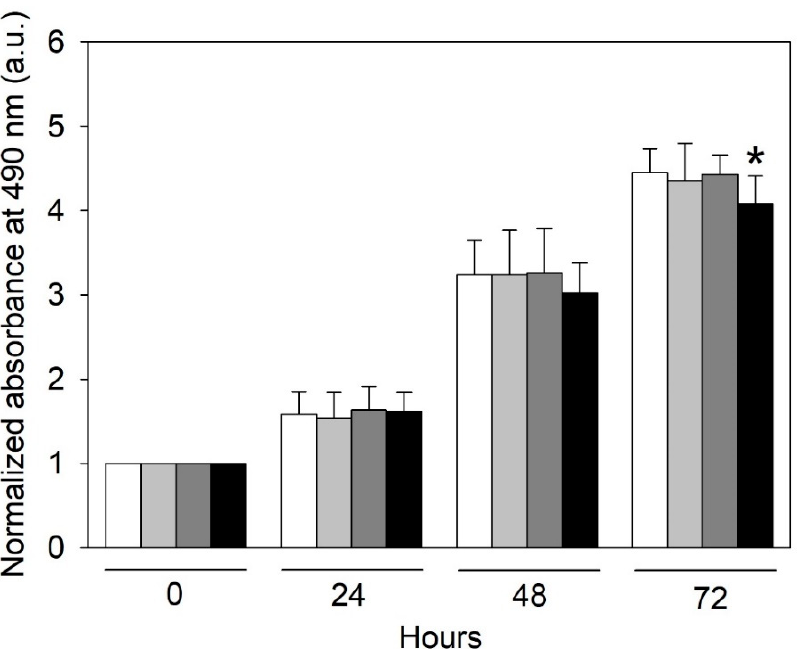
Figure 1. Effect of urea on HMEC-1 proliferation measured indirectly by the SRB assay. Histograms showing the mean absorbance measured at 490 nm in control cells (white histogram) and cells treated with 0.25 (light gray histogram), 2 (dark gray histogram), or 5 (black histogram) g/L urea for 0, 24, 48, or 72 h. Data are expressed as the mean ± SD. * p < 0 05.